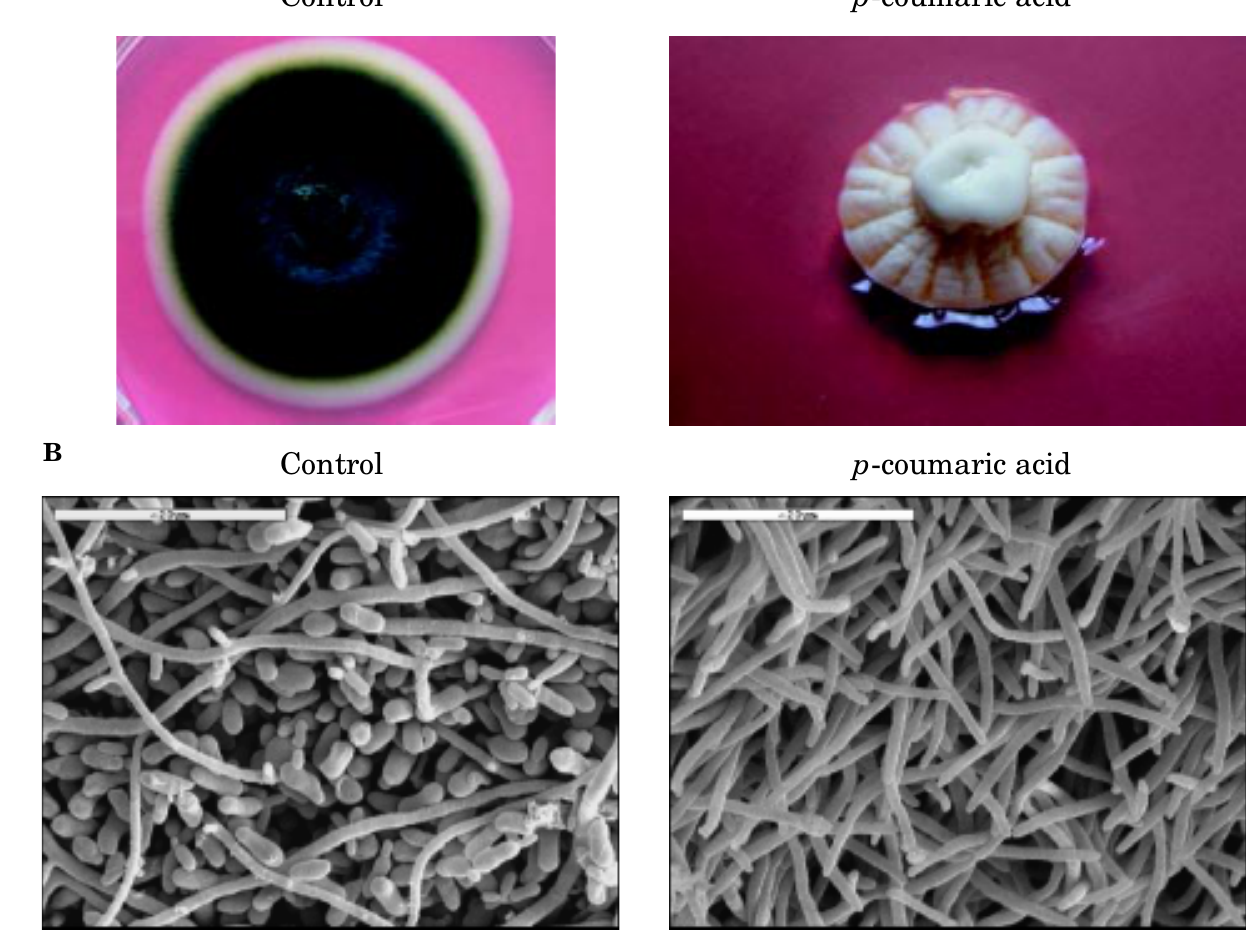
Fig. 5. A. Growth inhibition of P. chlamydospora mycelium by p -coumaric acid (3 g l -1 ) added to the culture medium. B. Scanning electron micrograph showing changes in hyphal morphology and sporulation ( (cid:1)